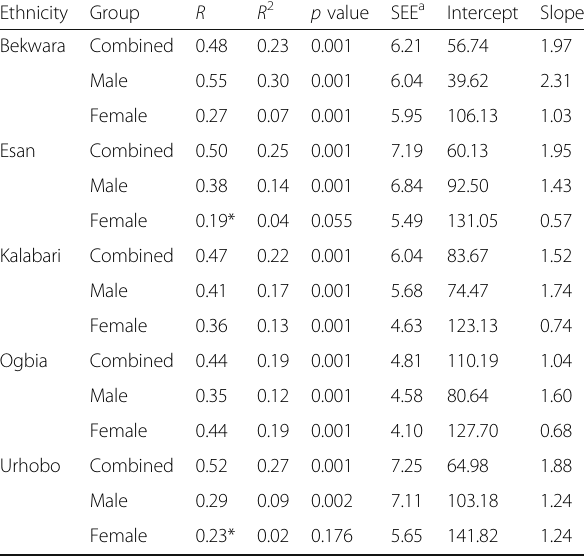
among the Urhobo (Table 6). Male data among the Bek- wara recorded the highest correlation ( ≈ 0.30). Male and combined data among the Bekwara and female data among the Ogbia had the highest value of correlation and R 2 . Table 7 showed regression equations for the esti- mation of height with head width in all the ethnic groups. Table 2 Result of simple regression analysis between the height and head circumference in all the ethnic groups Ethnicity Group R